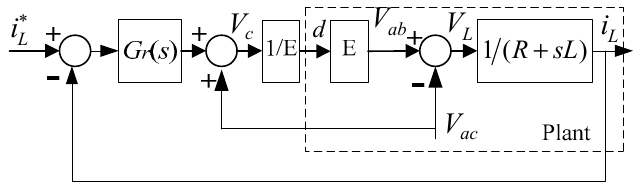
Figure 4. The control model of current loop.